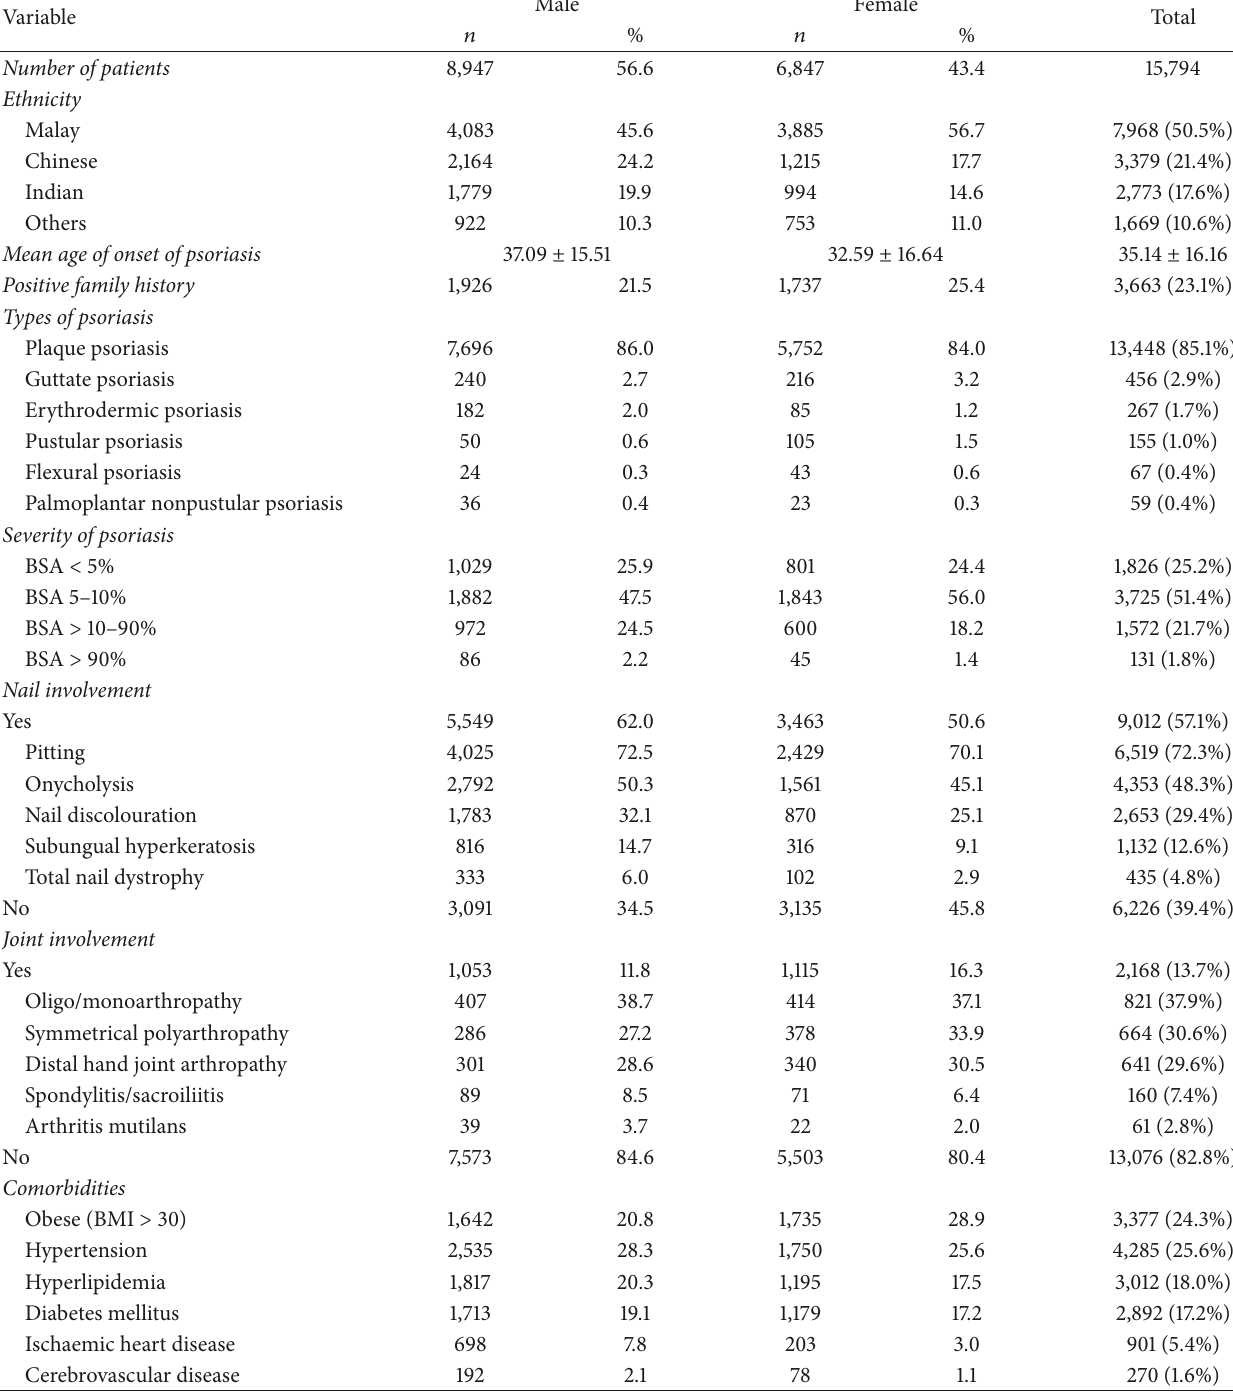
Table 1: Patients’ characteristics at